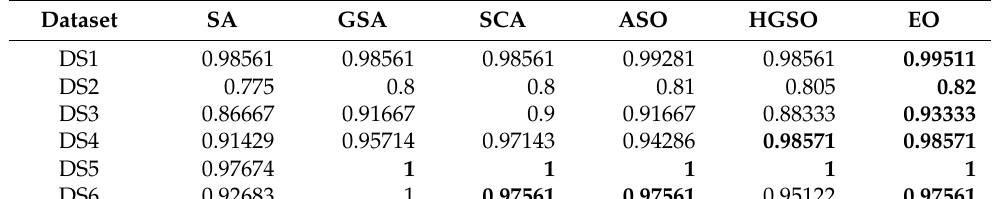
Table 4. Best classification accuracy of all algorithms.